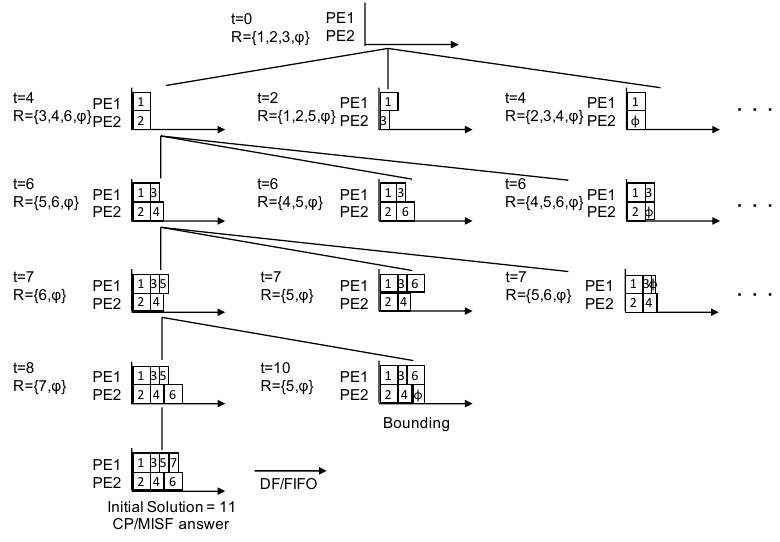
Figure 4. Partial search tree in